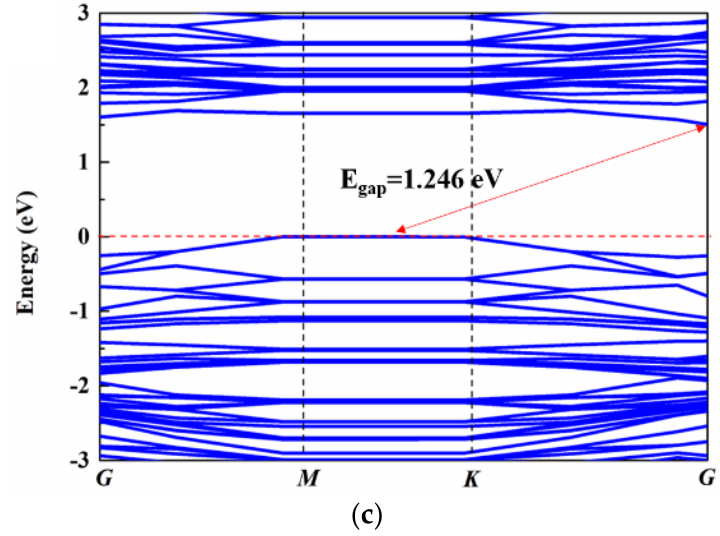
Figure 2. Energy band structure of WS 2 and graphene/WS 2 composites. ( a ) Energy band of WS 2 , energy band of graphene/WS 2 composites ( b ) before adsorbing NH 3 , and ( c ) after adsorbing NH 3 .